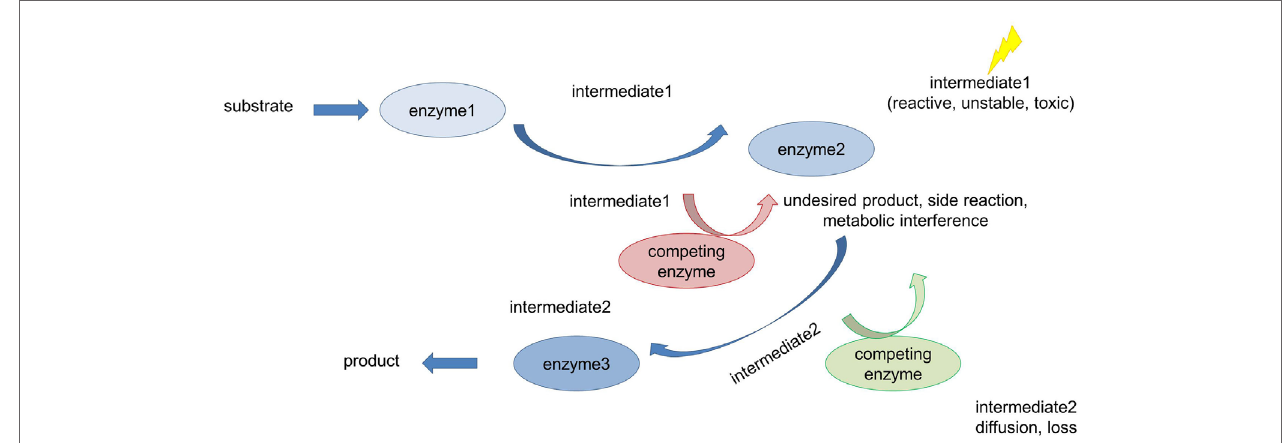
FiGURe 1 | Metabolic challenges cells have to deal with . Many metabolic reactions are characterized by low productivity and product yield for the following reasons: accumulation of toxic and/or unstable intermediates, loss of intermediates due to diffusion into the bulk phase (long distances between interacting proteins), and competing pathways (metabolic interference) also leading to undesirable side